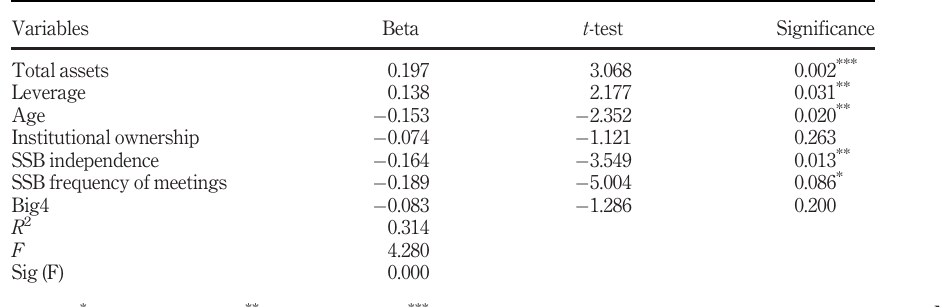
Table VII. Autocorrelation